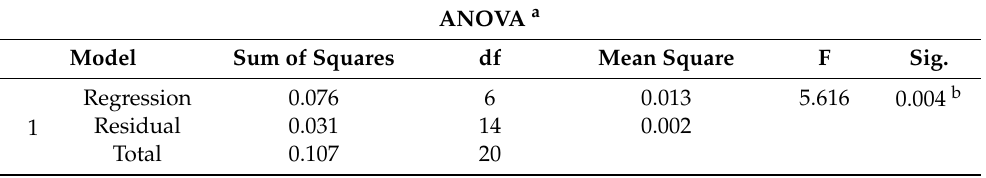
Table 8. ANOVA method for France.